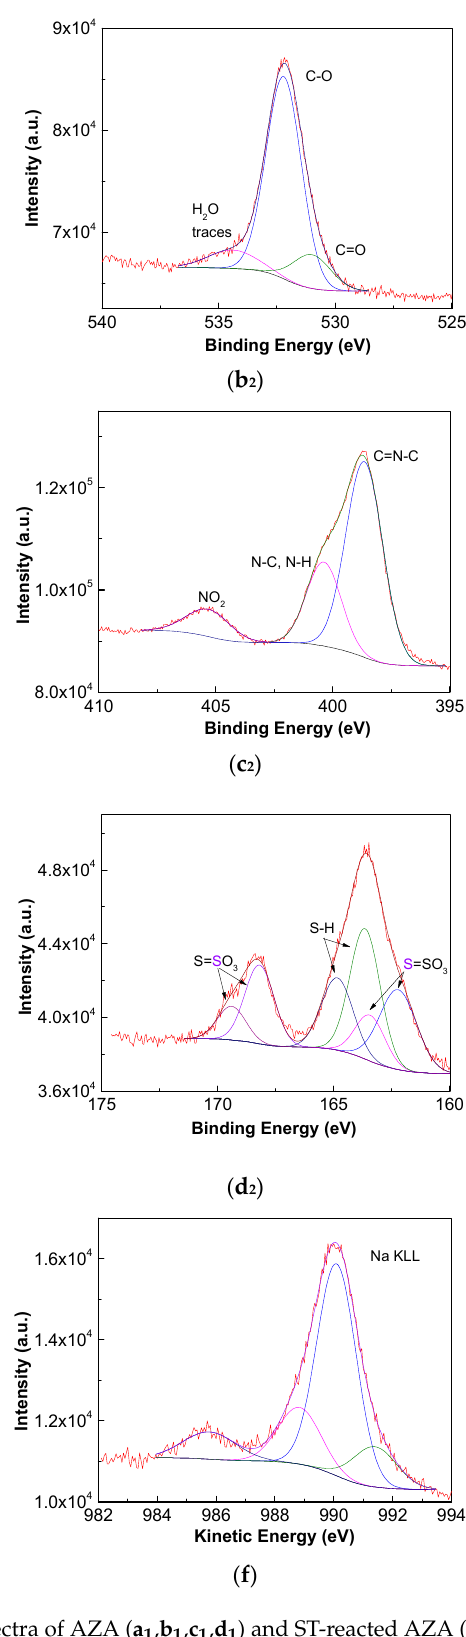
Figure 7. XPS C1s, O1s, N1s and S2p spectra of AZA ( a 1 , b 1 , c 1 , d 1 ) and ST-reacted AZA ( a 2 , b 2 , c 2 , d 2 ). ( e , f ) show the XPS Na1s spectrum and the Na KLL Auger spectrum, respectively, of ST-reacted